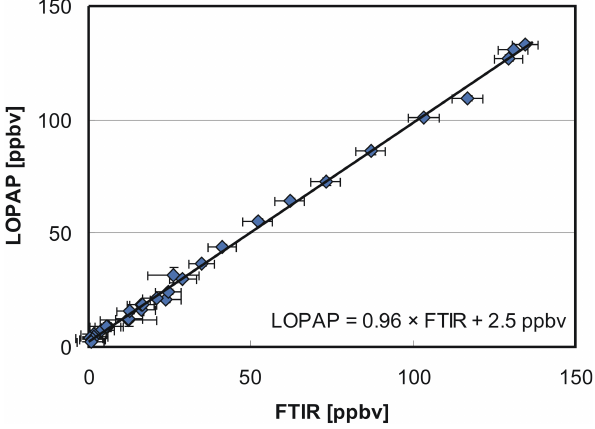
Fig. 6. Correlation of all LOPAP and FTIR NO complex photo-smog experiment, shown in Fig. 4. The error bars only represent the precision of both